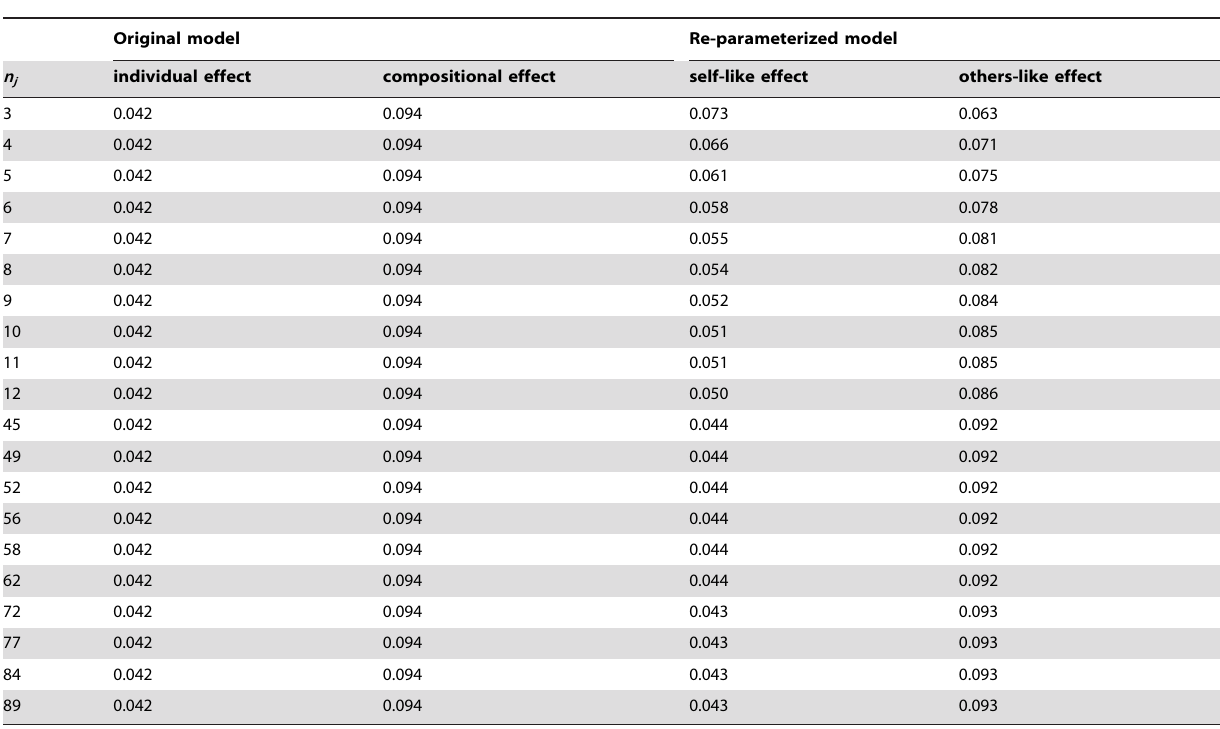
Table 6. Numerical outputs of cluster-mean centered self-included model and its re-parameterized form (as functions of the work unit size n j